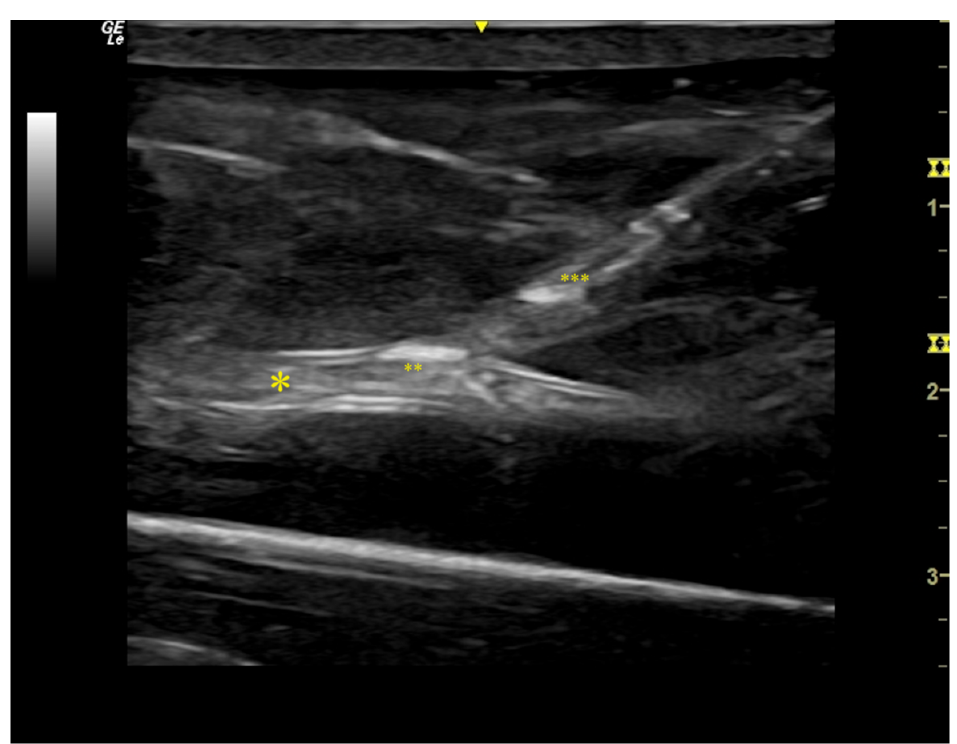
Figure 4. Vascular ultrasound imaging of pAVF training. Legend: positioning of Ellipsys ® catheter at anastomosis site, simulated artery *, arterial ** and venous *** device part, (cid:72) transducer‘s center marker.